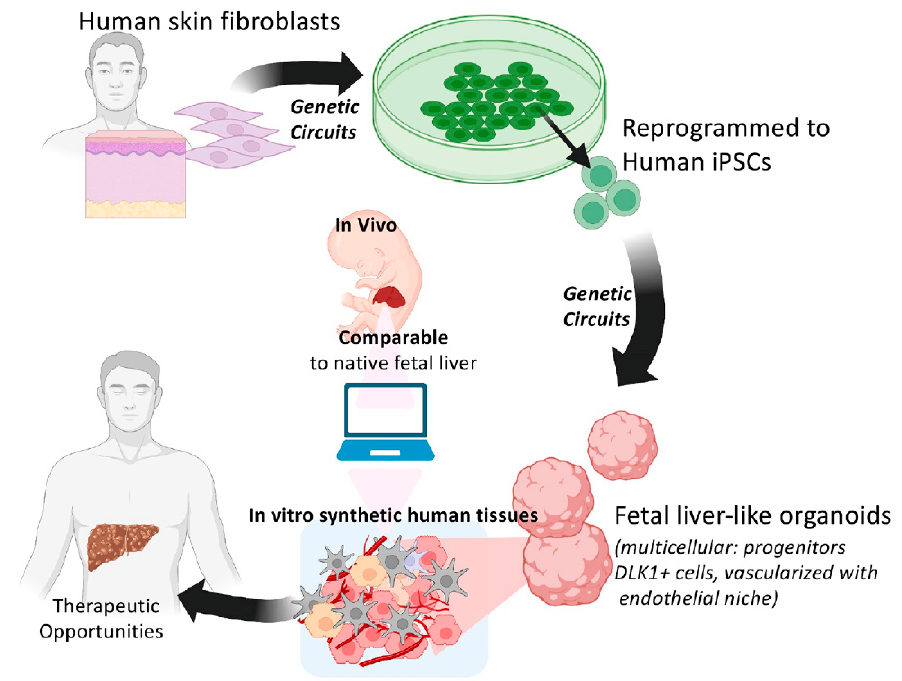
Figure 3. Generation of synthetic fetal liver organoids using human iPSCs can provide a novel platform for human liver repopulation during diseased conditions. Human skin cells can be reprogrammed to human iPSCs using reprogramming factors. Developed iPSCs can differentiate toward synthetic multicellular fetal liver organoids using, e.g., GATA6 genetic circuits. Produced organoids can represent a human cell source with a potentially competitive advantage for therapeutic liver repopulation.